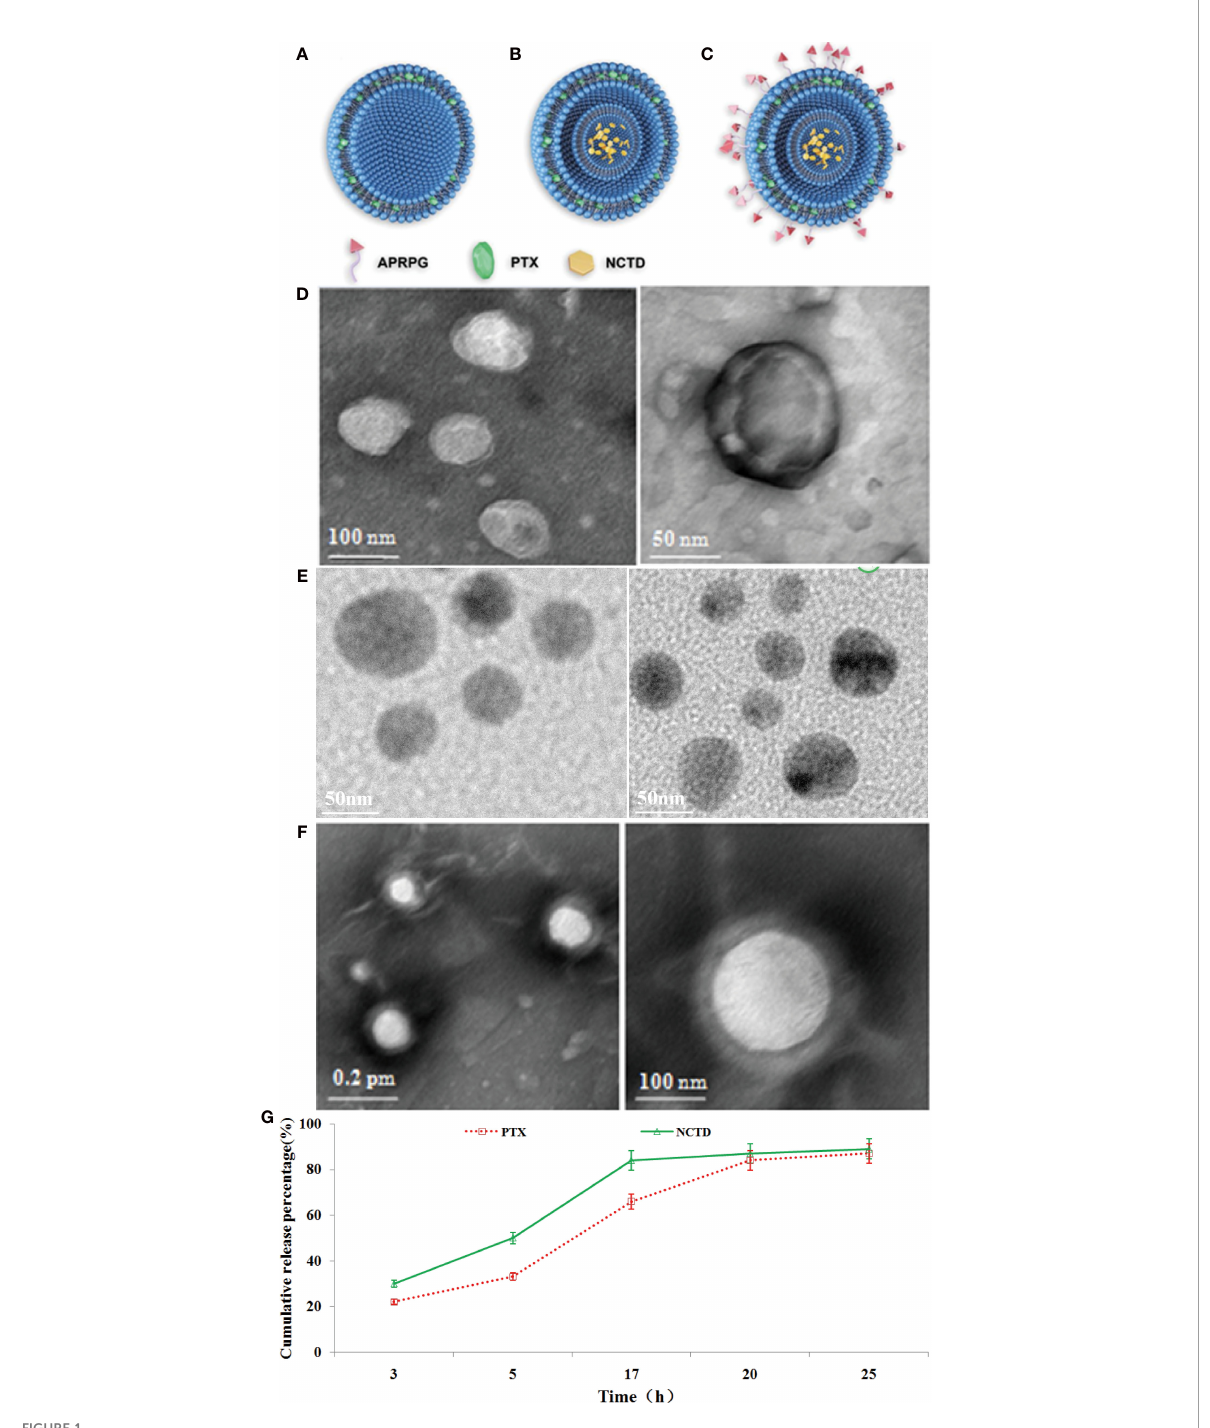
FIGURE 1 The structural, morphological, and release characteristics of PTX-NPs and PTX/NCTD-APRPG-NPs. Schematic illustration of the structure and composition of nanoparticles used in this study, including (A) PTX-loaded PLGA nanoparticles (PTX-NPs); (B) PTX/NCTD-loaded core – shell-type nanoparticles (PTX/NCTD-NPs); and (C) PTX/NCTD-loaded core – shell lipid nanoparticles modi fi ed with APRPG (PTX/NCTD-APRPG-NPs). The morphological characteristics of PTX-NPs and PTX/NCTD-APRPG-NPs, including the shape and size, were examined with transmission electron microscopy (TEM) and the Zetasizer instrument, respectively. (D) The shape of the PTX-NPs; (E) The shape of the PTX/NCTD-NPs; (F) The shape of the PTX/NCTD-APRPG-NPs; (G) in vitro release characteristic of PTX/NCTD-APRPG-NPs. PTX, paclitaxel; PLGA, poly(lactic-co-glycolic acid); NPs, nanoparticles; NCTD, norcantharidin; APRPG, tumor neovasculature-targeted peptide